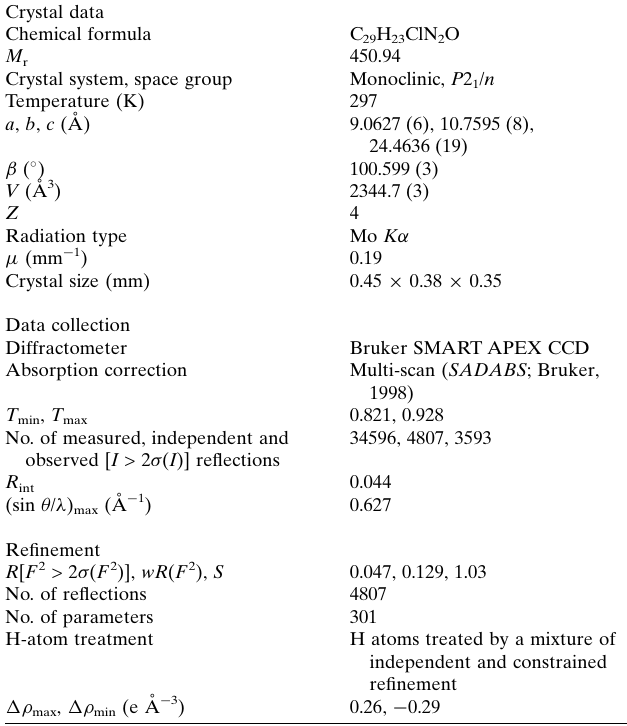
Table 2 Experimental details.